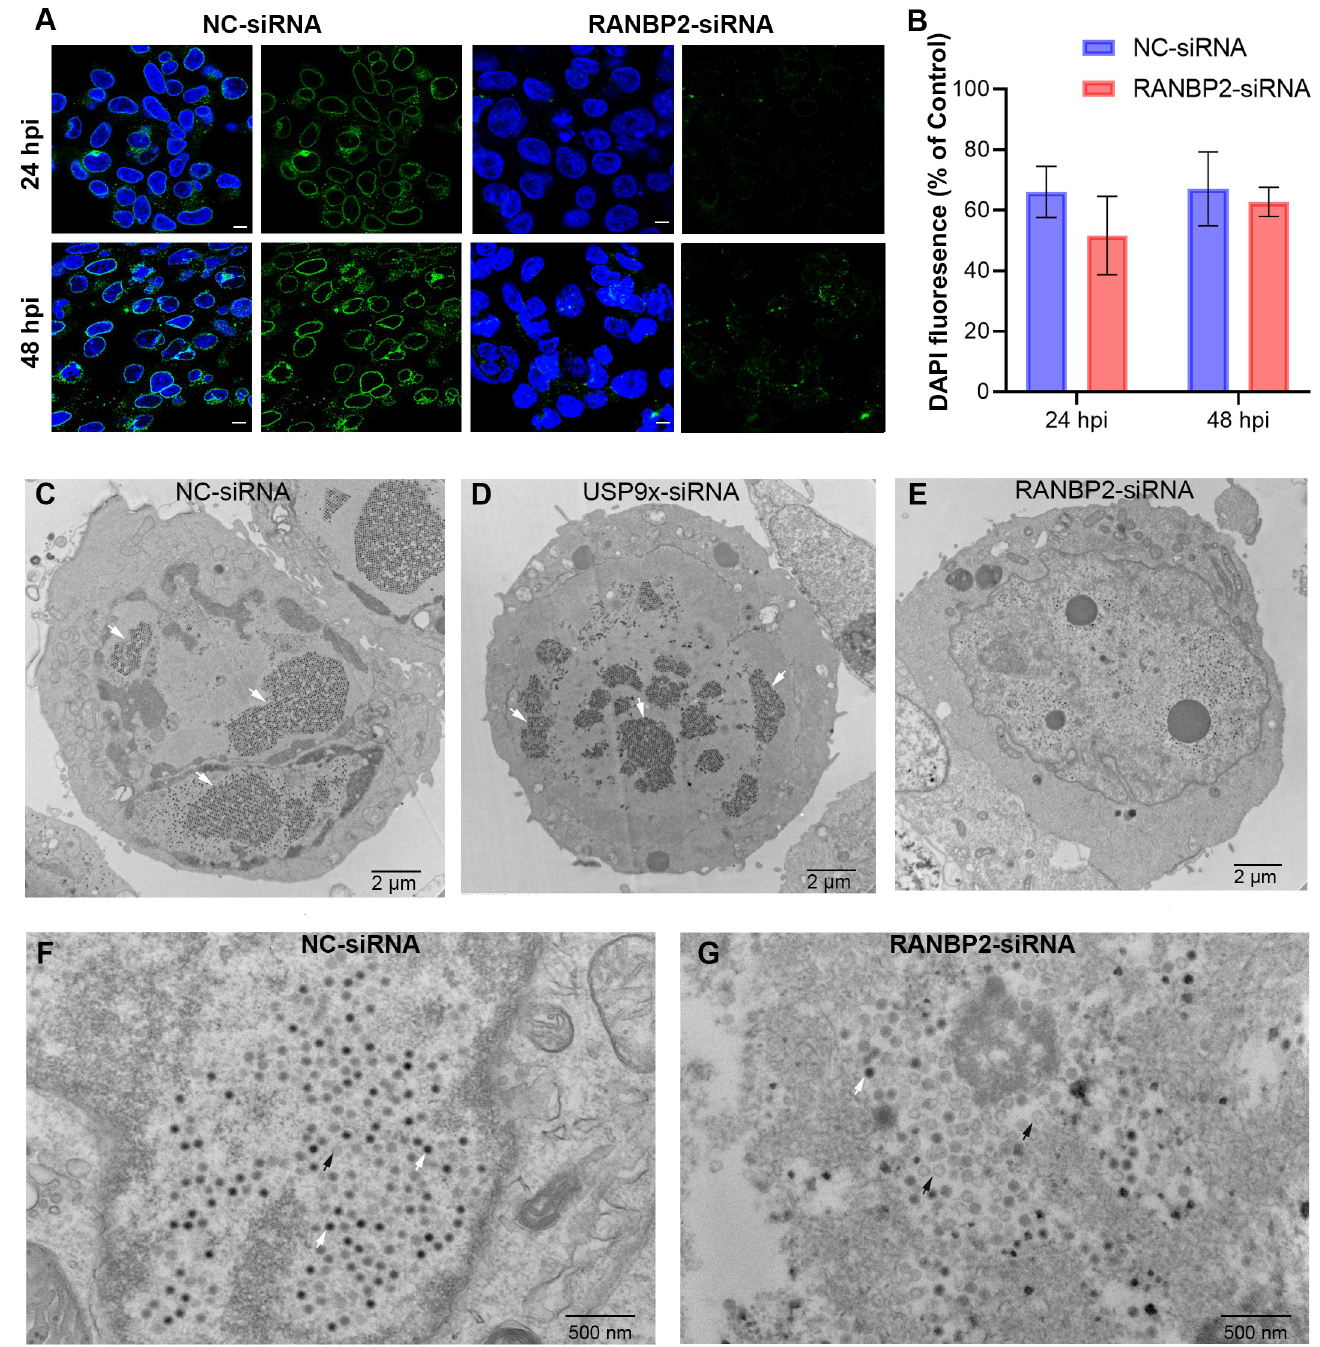
Fig 7. Human adenovirus interacts with RANBP2 for nuclear import and viral assembly. (A) DAPI nuclear (blue) and RANBP2 (green) staining of NC-siRNA and RANBP2-siRNA treated HEK293 cells, infected with HAdV-D37 at an MOI of 0.1 for 24 and 48 hrs, respectively. Scale bar = 10 μ m. (B) ImageJ quantification of DAPI fluorescence per cell, normalized to uninfected control cells (n = 100) and plotted as the percent of uninfected control fluorescence. (C) Transmission electron microscopy of NC-siRNA and (D) USP9x siRNA, and (E) RANBP2-siRNA treated HEK293 cells infected with HAdV-D37 at an MOI of 0.1 for 72 hrs. The specific MOI and time-points were chosen to establish viral replication while minimizing early cell death; HAdV-D37 infection at an MOI of � 1 in HEK293 cells leads to significant cytopathic effect within 24 hpi. White arrows over the nuclei show large paracrystalline viral arrays. Higher magnifications are shown for NC-siRNA (F) and RANBP2-siRNA (G) treated cells. The final data in (B) are presented as the mean ± SD of triplicate experiments. Statistical significance was performed with unpaired t-test (two-tailed). No statistically significant differences were seen.